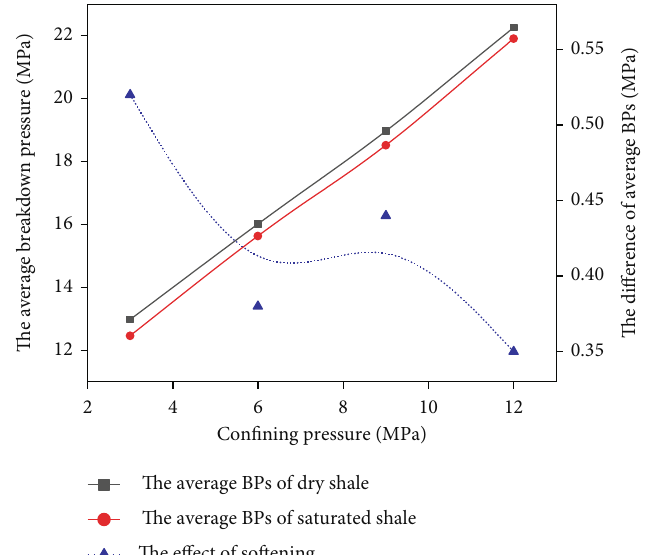
Figure 7: The breakdown pressure variation and the di ff erence of average breakdown pressure between dry and saturated shales without preconditioning under di ff erent con fi ning LN 2